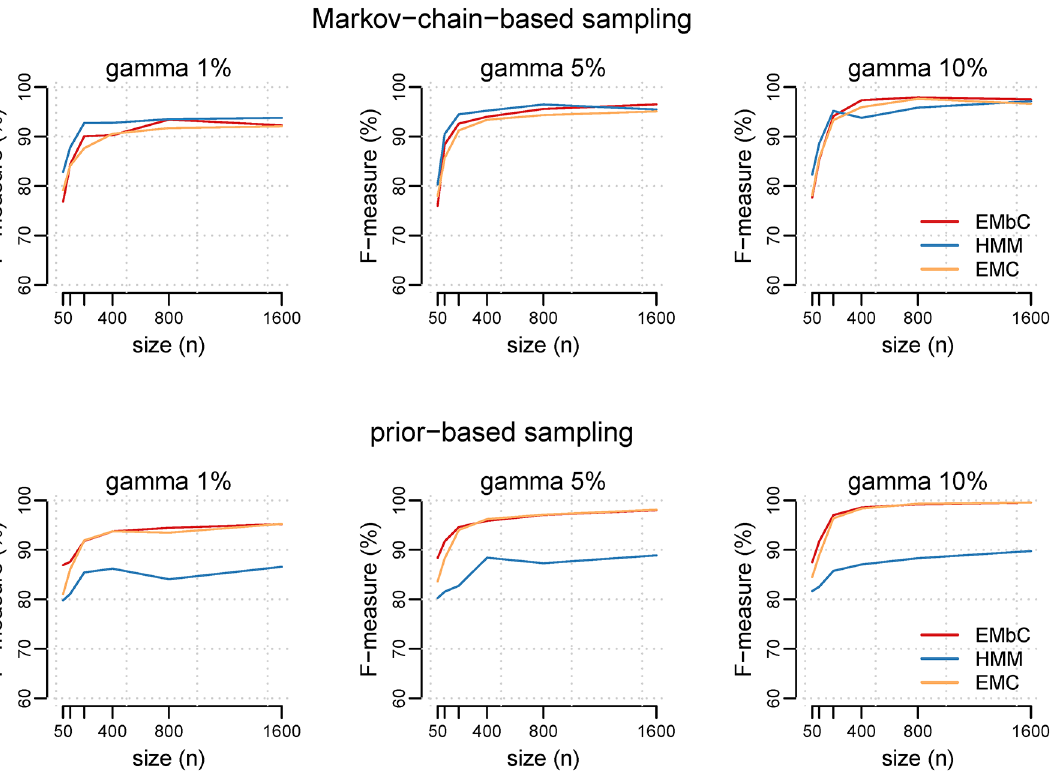
Fig 5. Performance comparison among EMbC, EMC, and HMM. Average performance of EMbC, EMC and HMM on 100 synthetic trajectories drawn from a GMM (4 components) using a Markov-chain-based sampling scheme (top panel) and a prior-based sampling scheme (bottom panel), for different trajectory sizes ( n = {50,100,200,400,800,1600}) and definition of the binary regions ( γ = {0.01,0.05,0.10}). Values of performance are given in terms of F-measure.